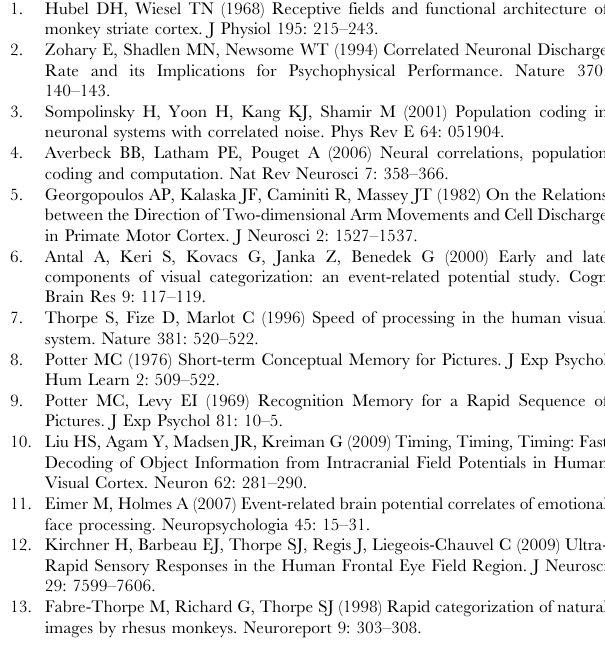
Figure S6 Effect of stimulus phase on spike latency tuning. The panels on the left side (A,C,E,G) depict results from a dataset in which all stimuli of the same orientation had identical initial phases; the panels on the right side (B,D,F,H) depict results from a dataset in which the initial phases were random. The two datasets were recorded in the same animal using the same electrode array. (A–B) PSTHs of two single cells. The stimuli were near the preferred orientation of the cells and the PSTH was constructed from 300 repetitions. For fixed initial phase, the PSTH is characterized by a periodic modulation whereas for random phases there is no such modulation. (C–D) First spike latency tuning curves of the neurons in (A) and (B). (E–F) Distribution of latency tuning modulation amplitude, B , in the two datasets. The substantial tuning of the response latency in the random phase dataset cannot be attributed to the stimulus initial phase. The inset in (F) shows the two cumulative distribution functions (black for the fixed phase dataset and blue for the random phase dataset). The similarity of the two distributions indicates that there is no significant difference between the orientation tuning levels of first spike latencies in the two datasets. (G–H) Mean neurometric curves using the first spike latency (red), second spike latency (green), third spike latency (blue) and the firing rate (black). Error bars represent the standard deviation and are shown only for the rate and the first spike latency neurometric curves. The fact that performance is similar indicates that our results reflect the tuning of the first spike latency to stimulus orientation and not the initial phase of the stimulus. (TIF) Text S1 A simple model for studying the effect of pairwise correlations on tWTA